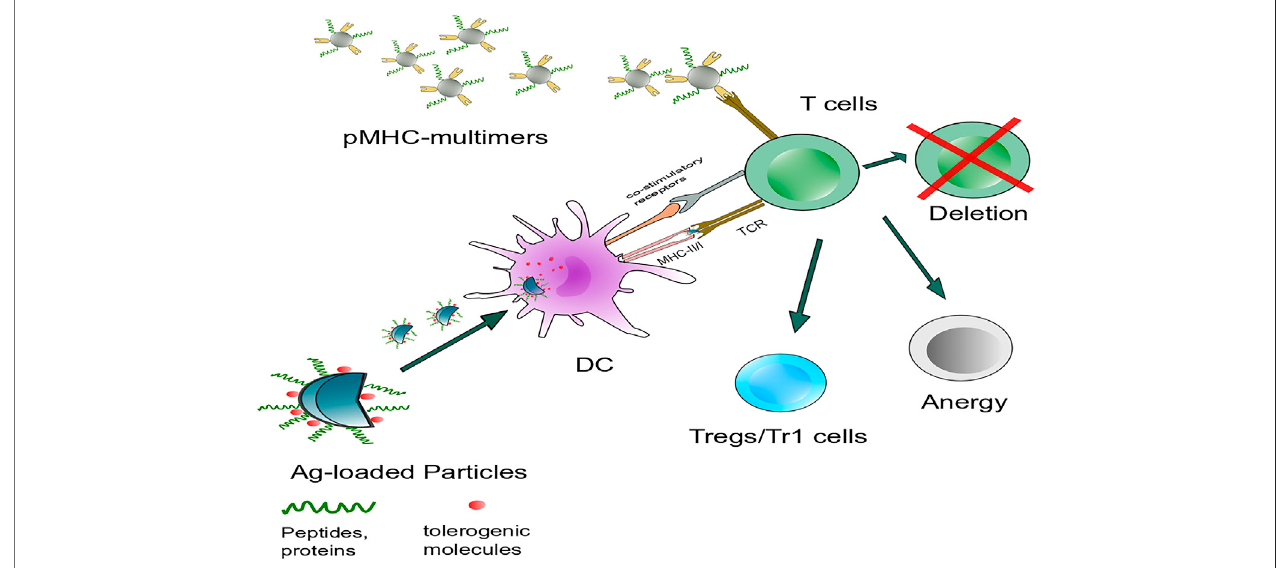
FIGURE 3 | Intervention of antigen-speci fi c autoimmunity is mainly concerned with two aspects: Targeting DCs or autoreactive lymphocytes to induce immune tolerance. Nanoparticles carry speci fi c autoantigens with or without tolerogenic molecules that target antigen-presenting cells such as DCs in vivo and interfere with autoreactive T cells, including autoreactive T cell anergy and apoptosis and the induction of Tregs or Tr1 cells. Another strategy is systemic delivery of NPs. Coated with disease-relevant pMHC multimers targeting cognate autoantigen-experienced T-cell directly, leading to the formation and expansion of cognate TR1